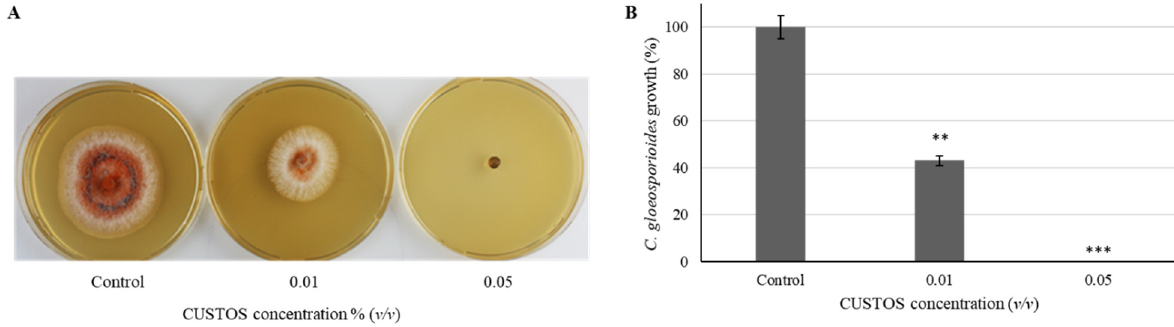
Figure 2. Inhibition by CUSTOS of fungal growth under lab conditions. After 5 dpi, the concentration at 0.05% completely inhibited the growth of Colletotrichum gloeosporioides , while less growth was observed at 0.01%. ( A , B ). Bars represent standard deviation of three replicates and significant changes are marked: ** p < 0.01; *** p < 0.001 (Student’s t -test).